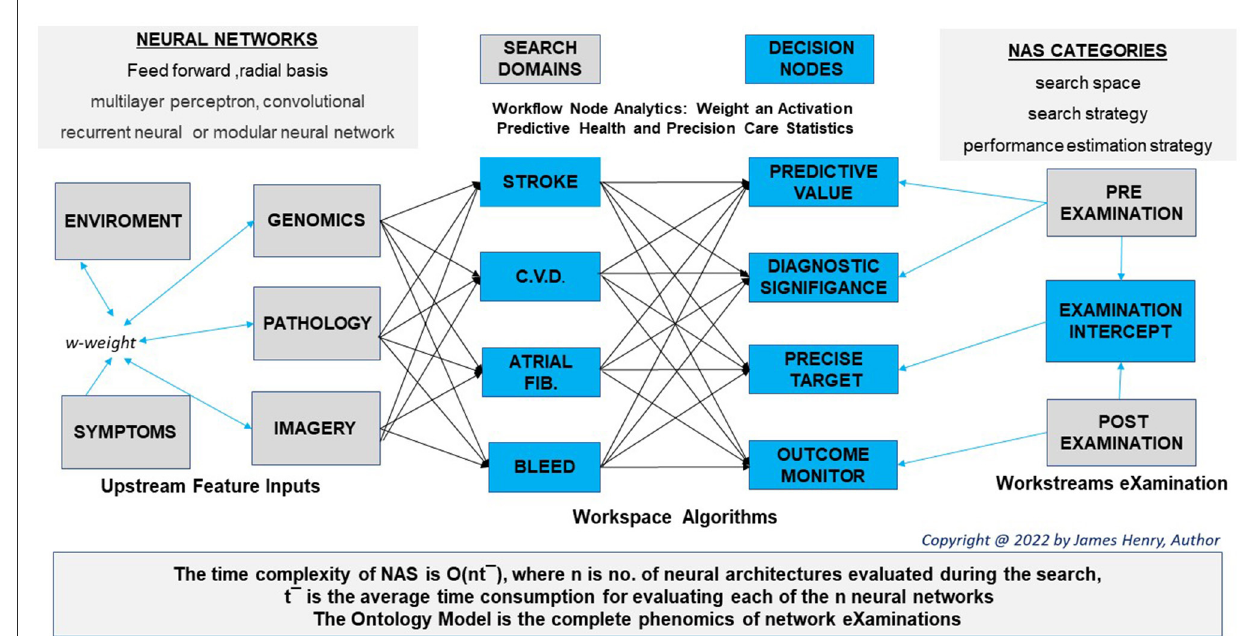
FIGURE2 Workflow structure.